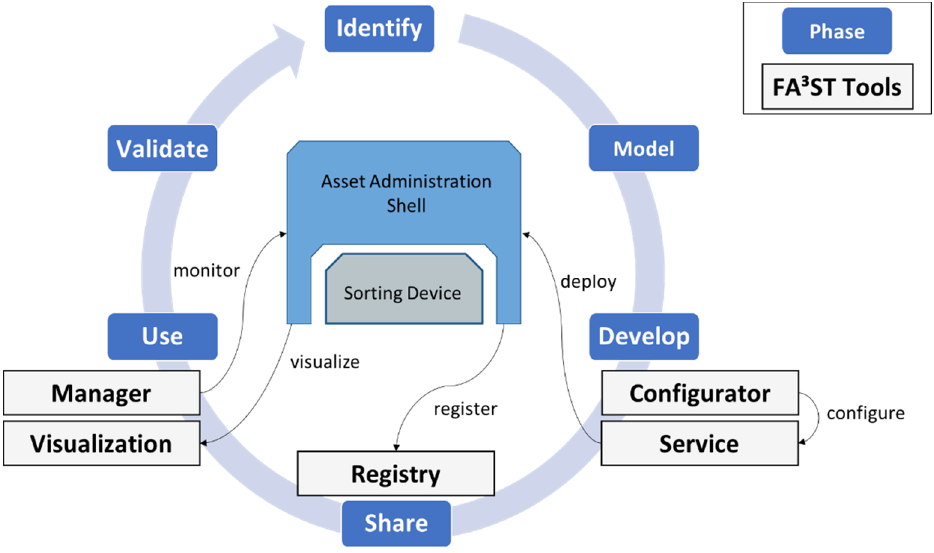
Figure 13. Subset of FA 3 ST applied to create a DT for the demo use case.